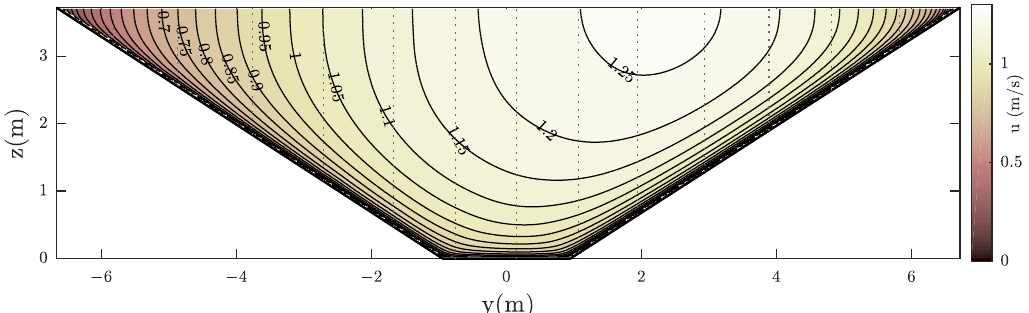
Figure 6. Hydraulic model results for measurement 2b in section GG7. The position of the measured verticals is indicated by a grey dashed line.